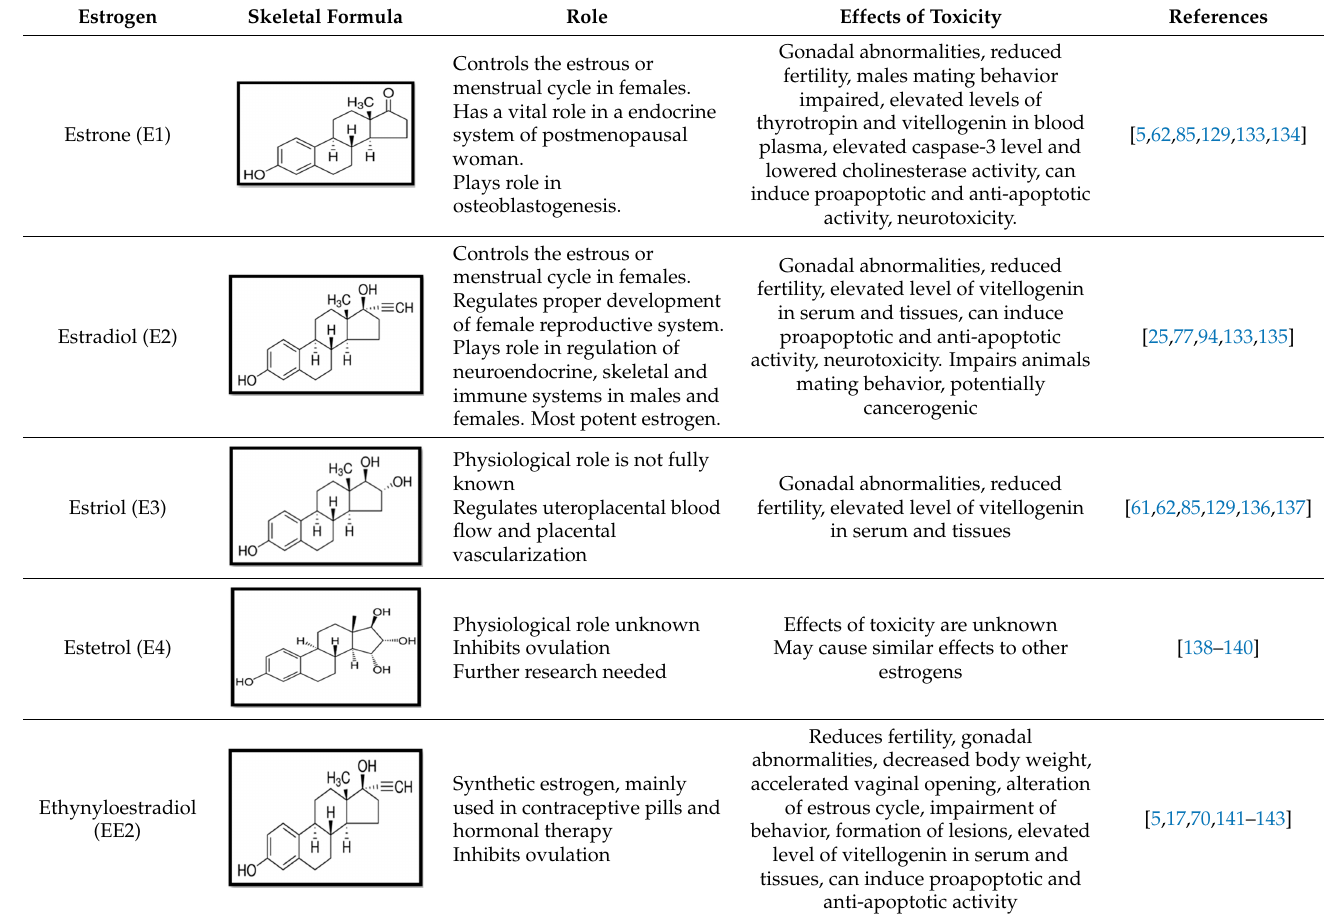
Table 1. Summary of the effects of estrogens.